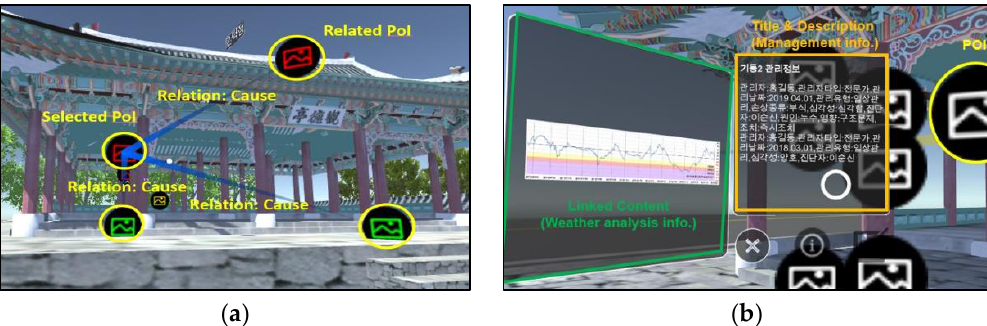
Figure 10. An example of using linker metadata: ( a ) an example of implementation of the xAnchor linker in remote diagnosis in virtual reality (VR) and ( b ) an example of implementation of the content linker in remote diagnosis in